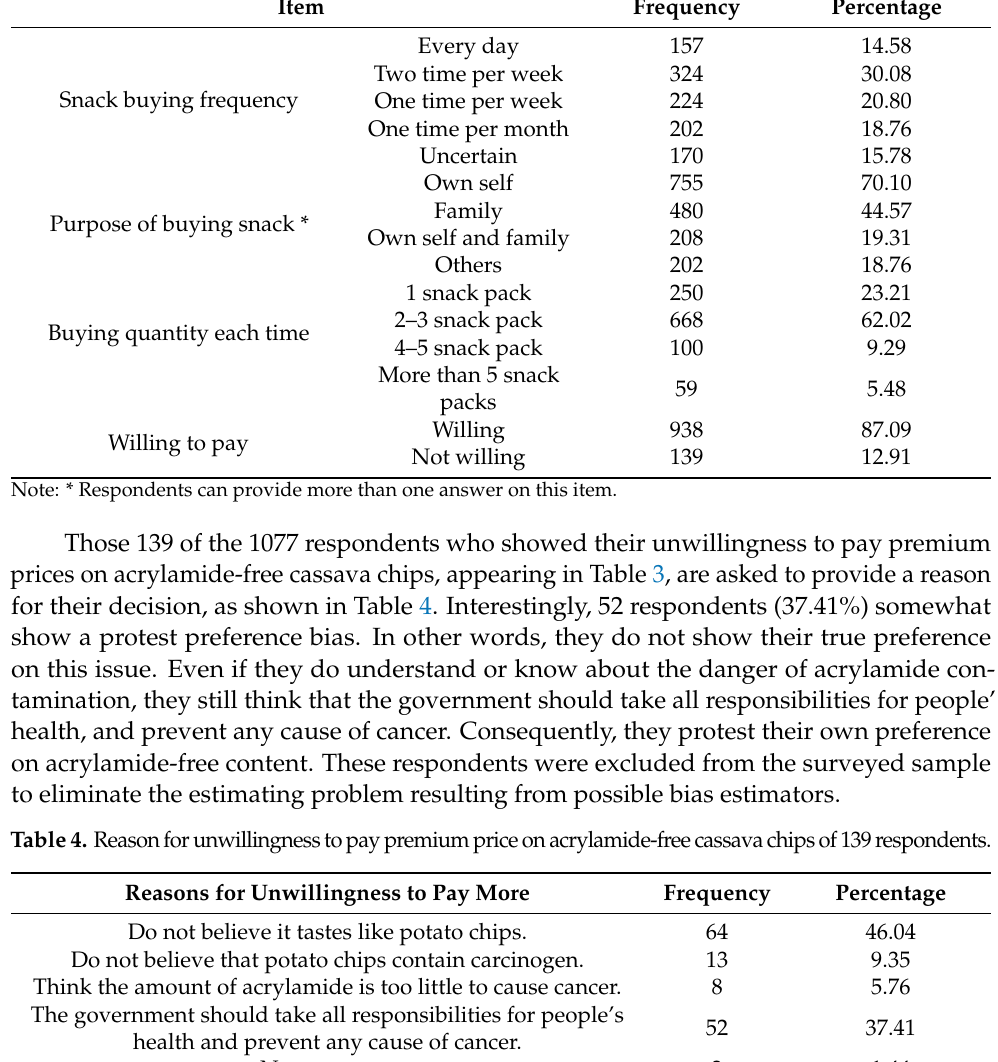
Snack buying frequency